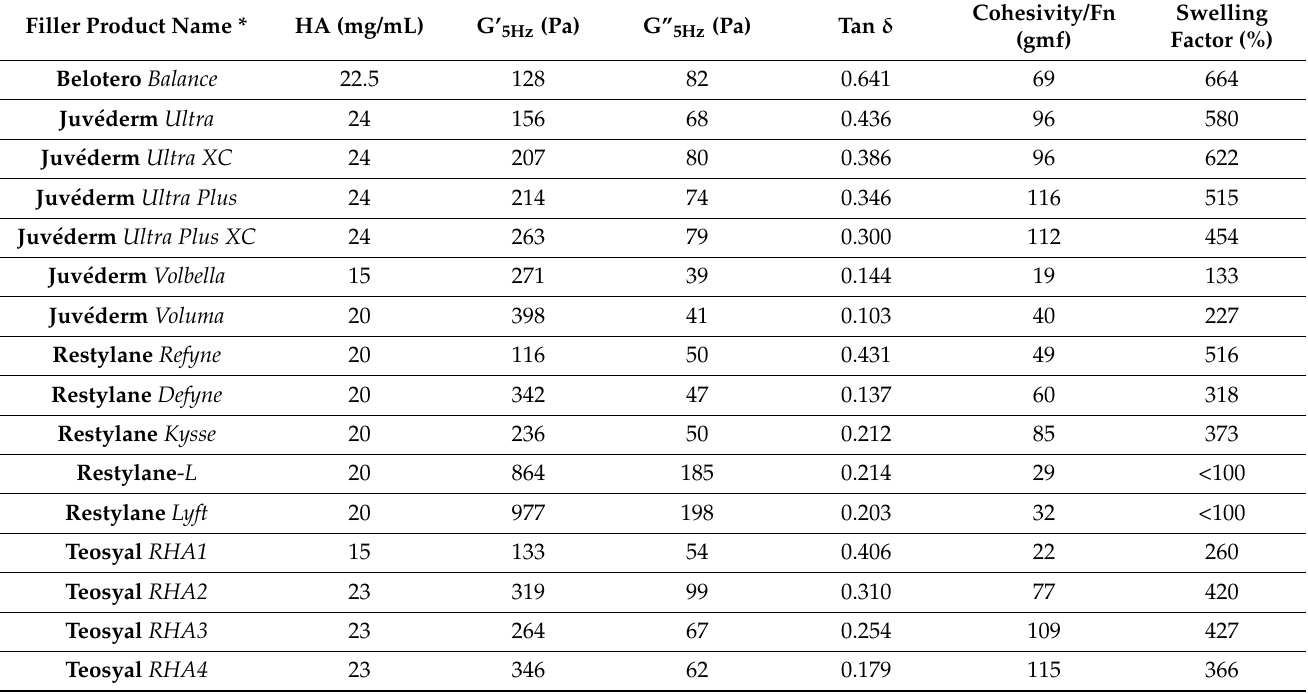
Table 1. Rheological properties of U.S. hyaluronic acid-based dermal filler brands. Data adapted from de la Guardia et al.